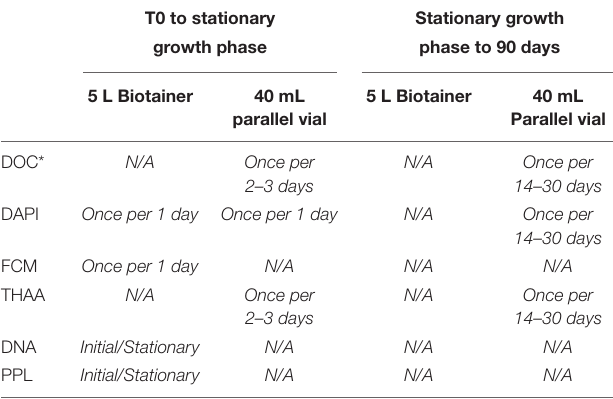
TABLE 1 | Example sampling frequency schedule from the OM remineralization